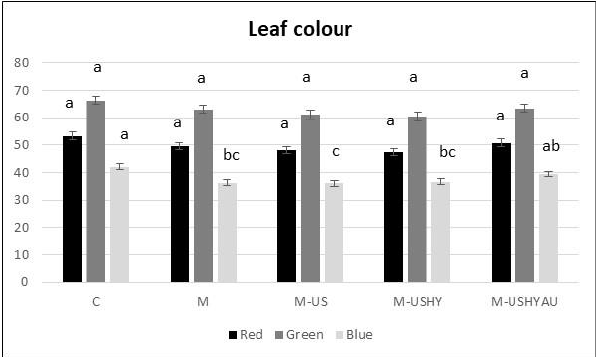
Figure 6. Leaf colour (red, green, and blue). Data are means ± standard error. Values followed by different letters are significantly different ( p ˂ 0.05). The values are the means of data from 12 plants for each replica.